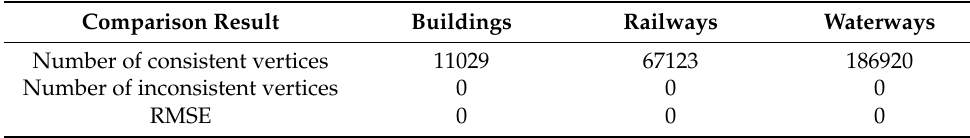
Table 2. The difference between the E-Wed map and the W-Eed map. Comparison Result